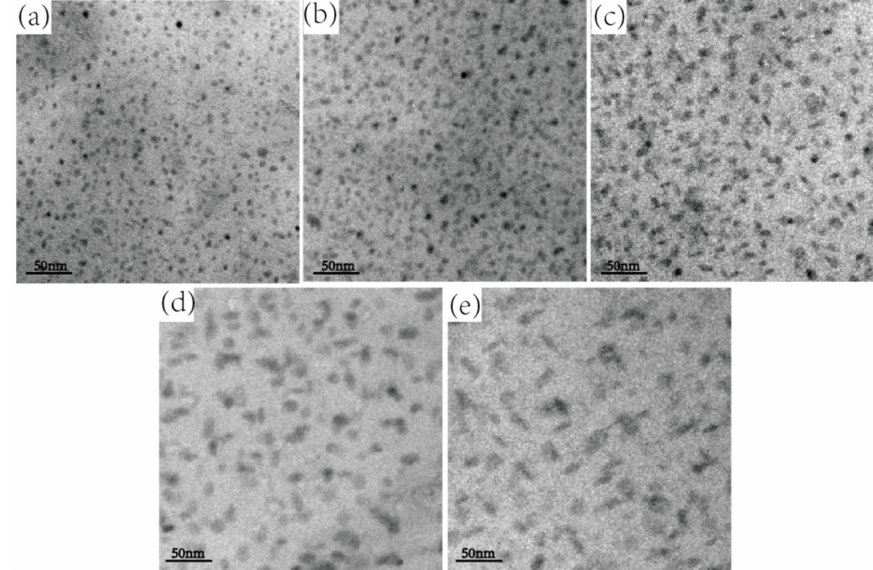
Figure 3. The intragranular precipitate phase of the alloys (in <001> Al zones axis): ( a ) Alloy 1, aging 61 h;